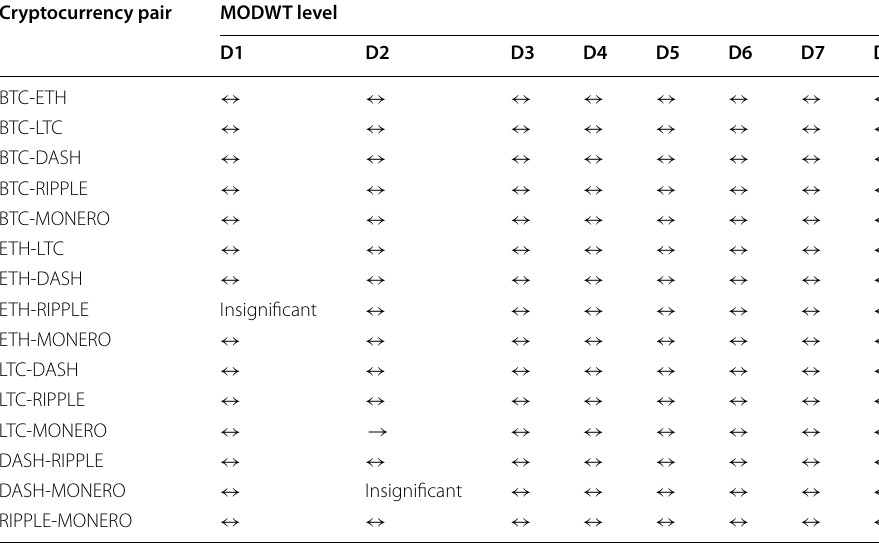
Table 3 Non‑linear directional Granger causality Cryptocurrency